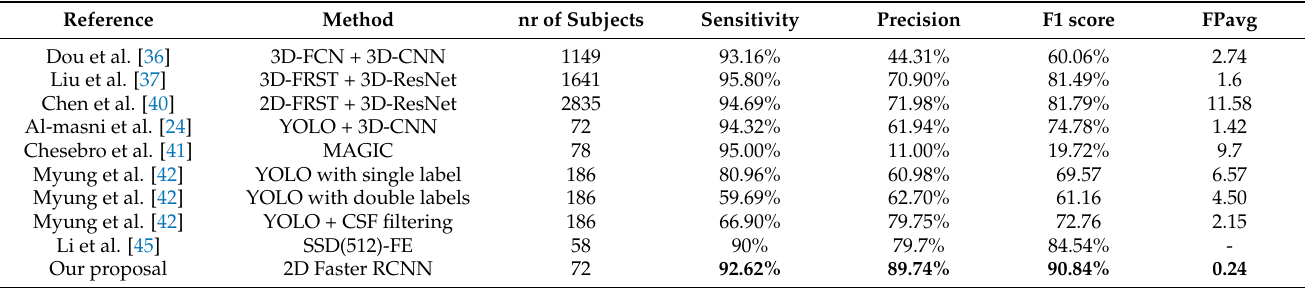
Table 8. Final results compared with other research. (The best result is marked in bold.)